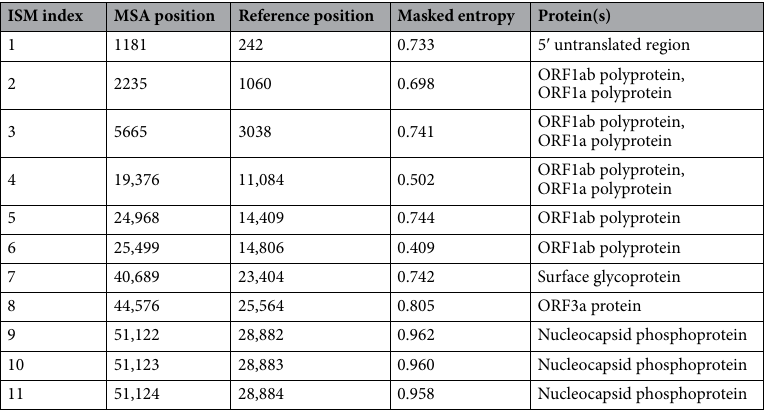
Table 1. Shows 11 positions in the SARS-Cov2 genome selected for constituting informative subtype markers (ISMs). ISM index ISM position index, MSA position base-pair position in the reference genome post multiple sequence alignment, Reference position base-pair position in the reference genome sequence, Masked entropy masked entropy value at respective ISM position, Protein(s) protein(s) encoded by the gene in this